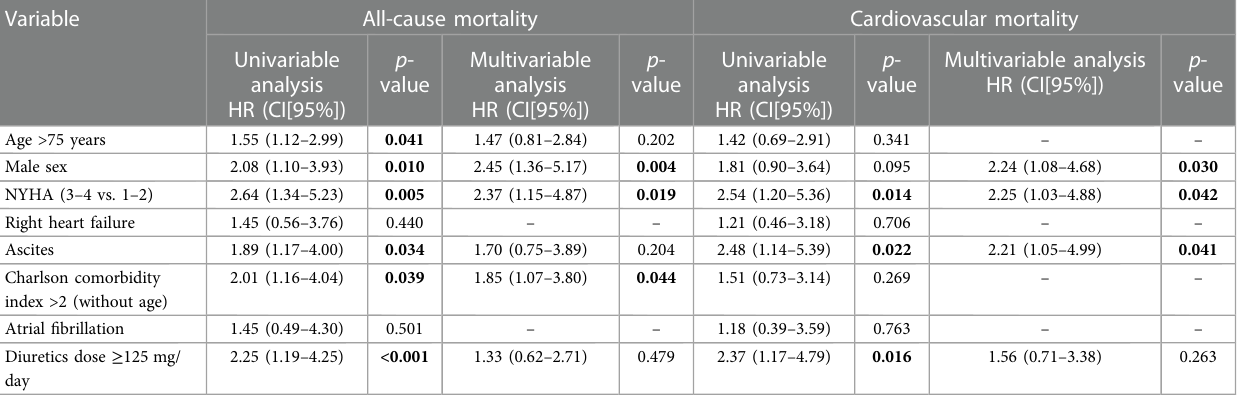
TABLE 3 Clinical factors associated with all cause and cardiovascular mortality in patients with a tricuspid coaptation gap ≥ 10 mm. Variable